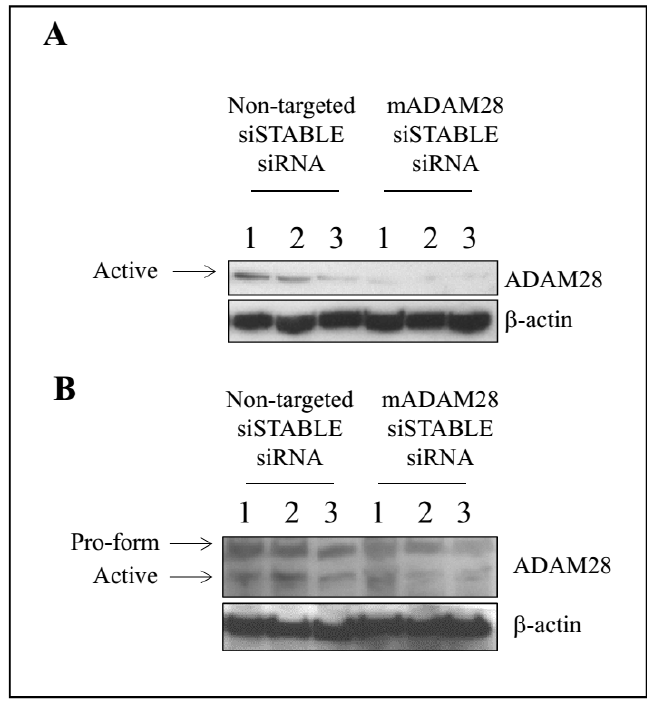
Figure 5. In vivo knock-down of ADAM28 in liver ( A ) and white adipose tissue ( B ) of high fat diet fed mice. The siRNA was administered for the final 2 weeks of the diet ( n = 3